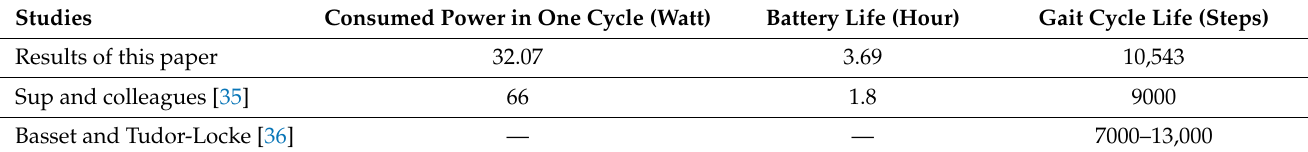
Table 7. Power consumptions, gait cycle life and battery life